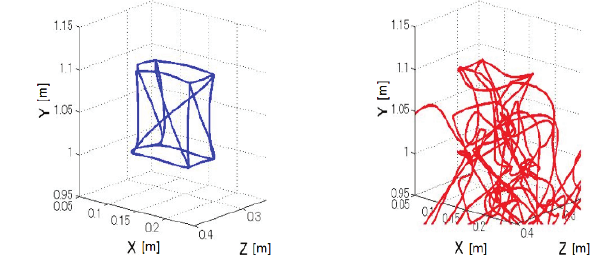
Figure 10. Task space trajectory during the test movement using IMLE, after motor babbling was performed first without tool, then with tool, and then again without tool. On the left: controlling the hand. On the right: controlling the tip of the tool.